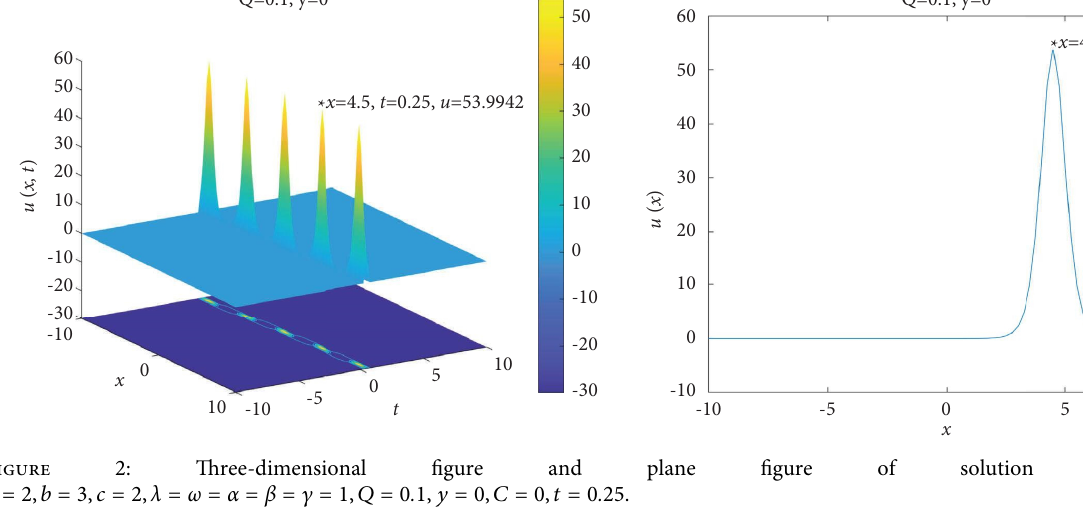
2: Tree-dimensional fgure